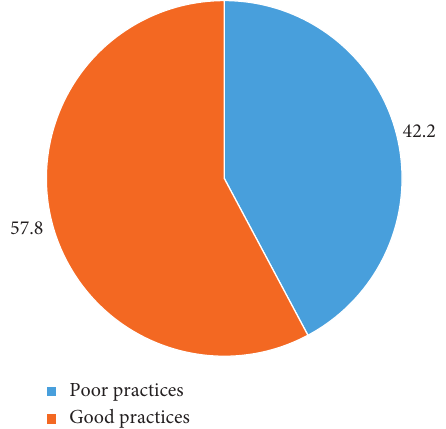
Figure 4: Overall level of practices on paediatric pain management. Source: field data Table 5: Logistic regression results showing factors associated with nurses’ paediatric pain management practices. Variable